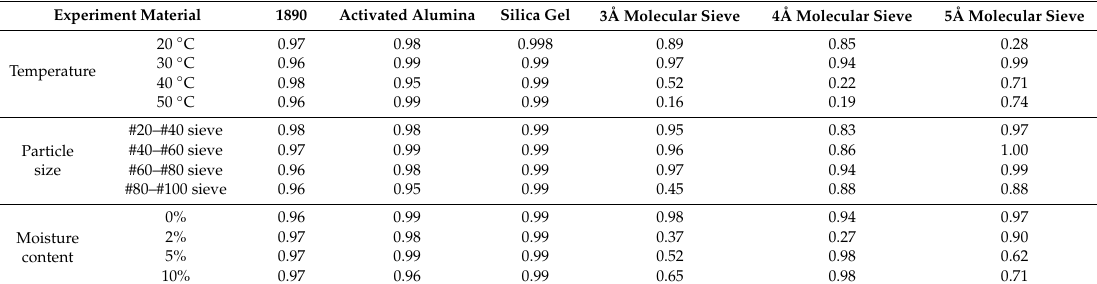
Table 1. Fitting results of materials under three factors.